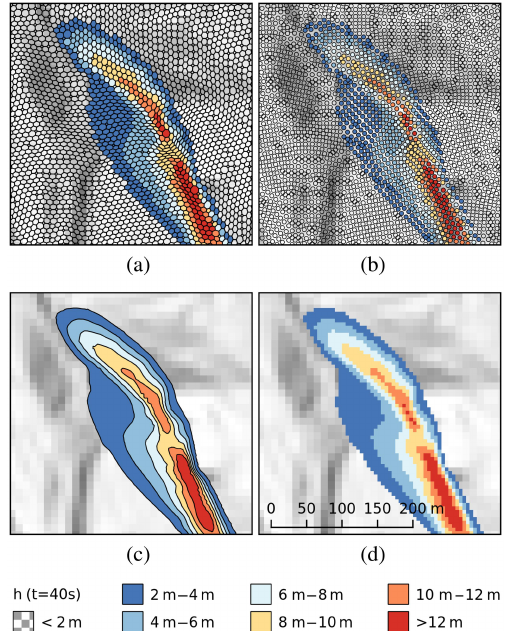
Figure 6. The flow thickness field h at time t = 40s for a simulation with mean cell size (cid:49) = 7 . 45m; first-order interpolations. The fig- ure shows four methods to export and analyse results in GIS: export of cells as polygons (a) ; export of cell centres as points (b) ; ex- port of contour lines as polygons (c) ; remapping of the unstructured finite-area mesh to a regular raster (d) . The raster has been created by converting point data to a raster file in QGIS. The resolution of the DEM is 10m, results have been mapped to a 5m grid. Terrain data: